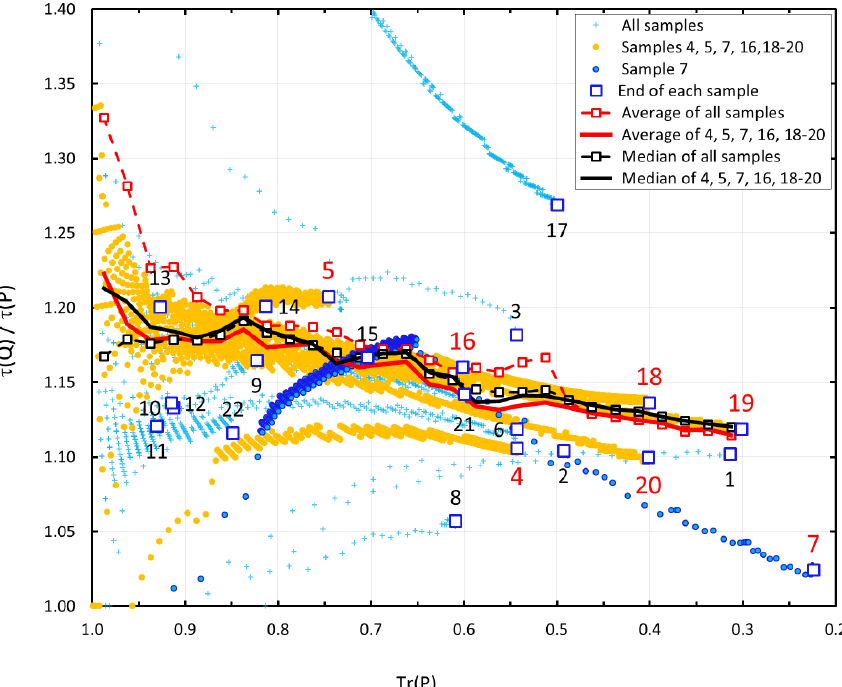
Figure 4. Ratio of non-loading-corrected optical depths ( τ = ln ( 1 / Tr )) of quartz and Pallflex filters, τ(Q) and τ(P) , respectively, at λ = 530nm at 1s time resolution. The numbers denote the value at the end of each sample. The red numbers are associated with the samples that were used for deriving C ref (quartz) in Sect. 3.1.2